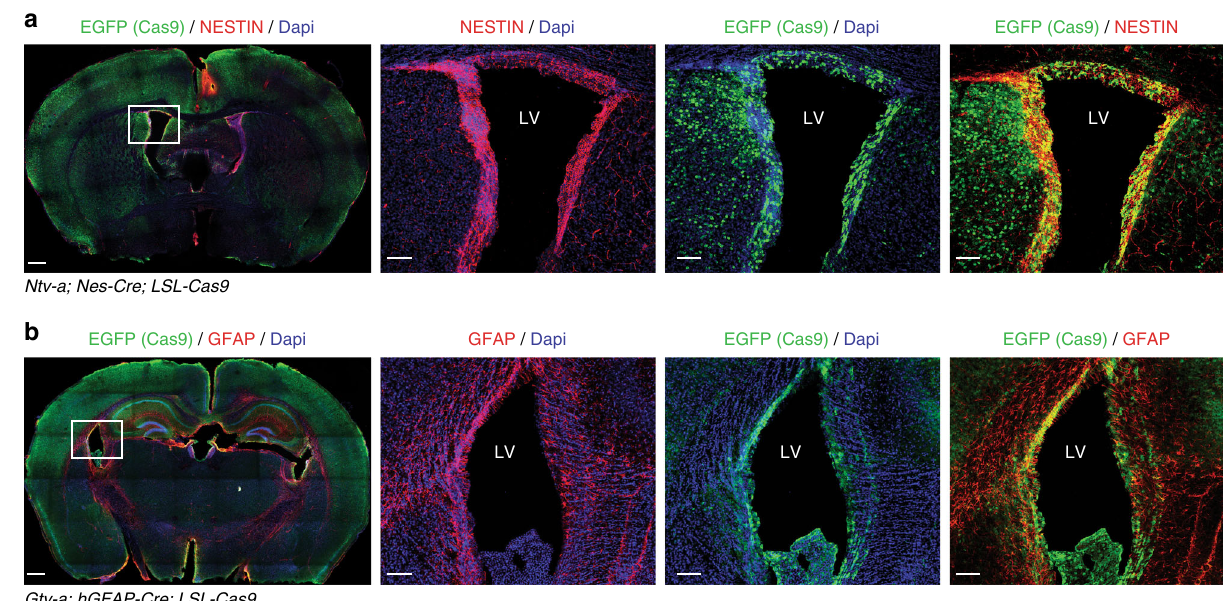
Fig. 1 Cas9 expression in the brain of TVA/Cas9 mouse strains. a , b Immuno fl uorescence staining performed on brain sections of four-week-old Ntv-a; Nes-Cre; LSL-Cas9 and Gtv-a; hGFAP-Cre; LSL-Cas9 mice with antibody against EGFP (Cas9), NESTIN and GFAP. CAS9 is widely expressed in the whole brain and co-localize with NESTIN and GFAP in the subventricular zone. Left panels: whole brain section; right panels: higher magni fi cation of the left panel inset. Scale bars: left panels, 500 μ m; right panels, 100 μ m. LV lateral